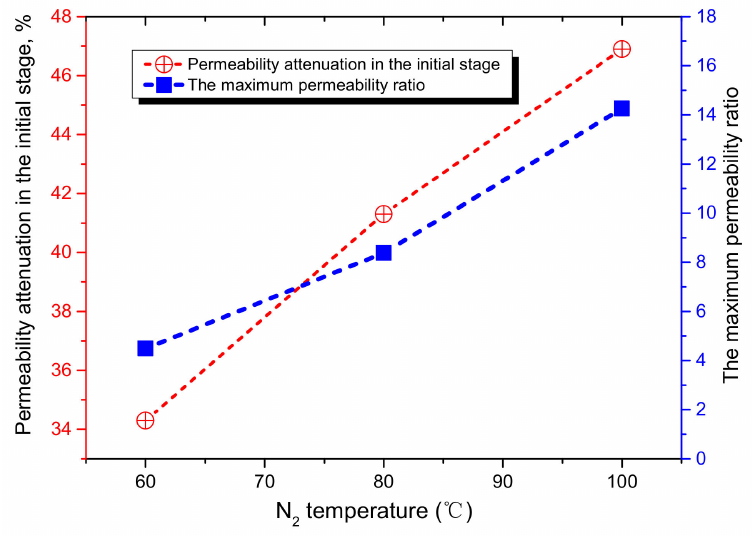
Figure 5. Variation of the permeability attenuation in the initial stage, and the maximum permeability ratio with the N 2